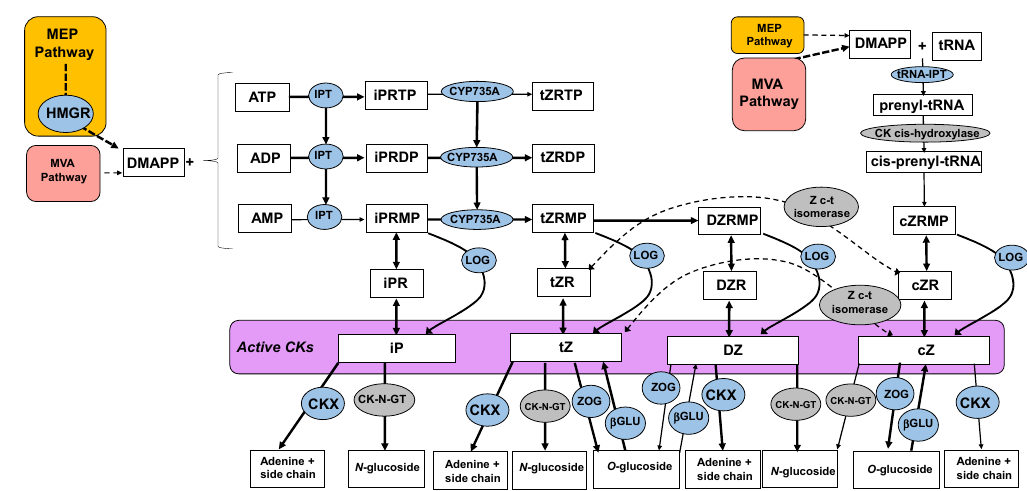
Figure 5. Cytokinin biosynthetic and catabolic pathways. Enzymes in blue are known and have been identified in kiwifruit; enzymes in grey are unknown and / or not identified in kiwifruit. Modified from [28,29]. β GLU, β -glucosidase; CK, cytokinin; CK-N-GT, cytokinin N -glucosyltransferase; CKX, cytokinin dehydrogenase; CYP735A, cytokinin hydroxylase; cZ, cis -zeatin; cZR, cZ riboside; cZRM( / D / T)P, cZ nucleotides; DMAPP, dimethylallyl pyrophosphate; DZ, dihydrozeatin; DZR, DZ, riboside; DZRM( / D / T)P, DZ nucleotides; HMGR, 3-hydroxy-3-methylglutaryl-coenzyme A reductase; iP, N 6 -( ∆ 2 -isopentenyl)adenine; iPR, iP riboside; iPRM( / D / T)P, iP nucleotides; IPT, adenosine phosphate-isopentenyltransferase; MEP, methylerythritol phosphate pathway; LOG, LONELY GUY (cytokinin riboside 5’-monophosphate phosphoribohydrolase); MVA, mevalonate pathway; tRNA, transfer RNA; tZ, trans -zeatin; tZR, tZ riboside; tZRM( / D / T)P, tZ nucleotides; ZOG, zeatin O -glucosyltransferase.